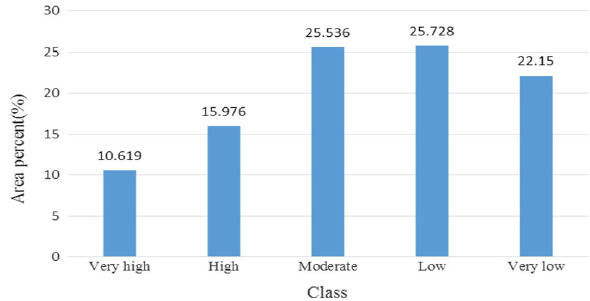
Fig. 4 The area related to each class of the eco-hydrologic stability